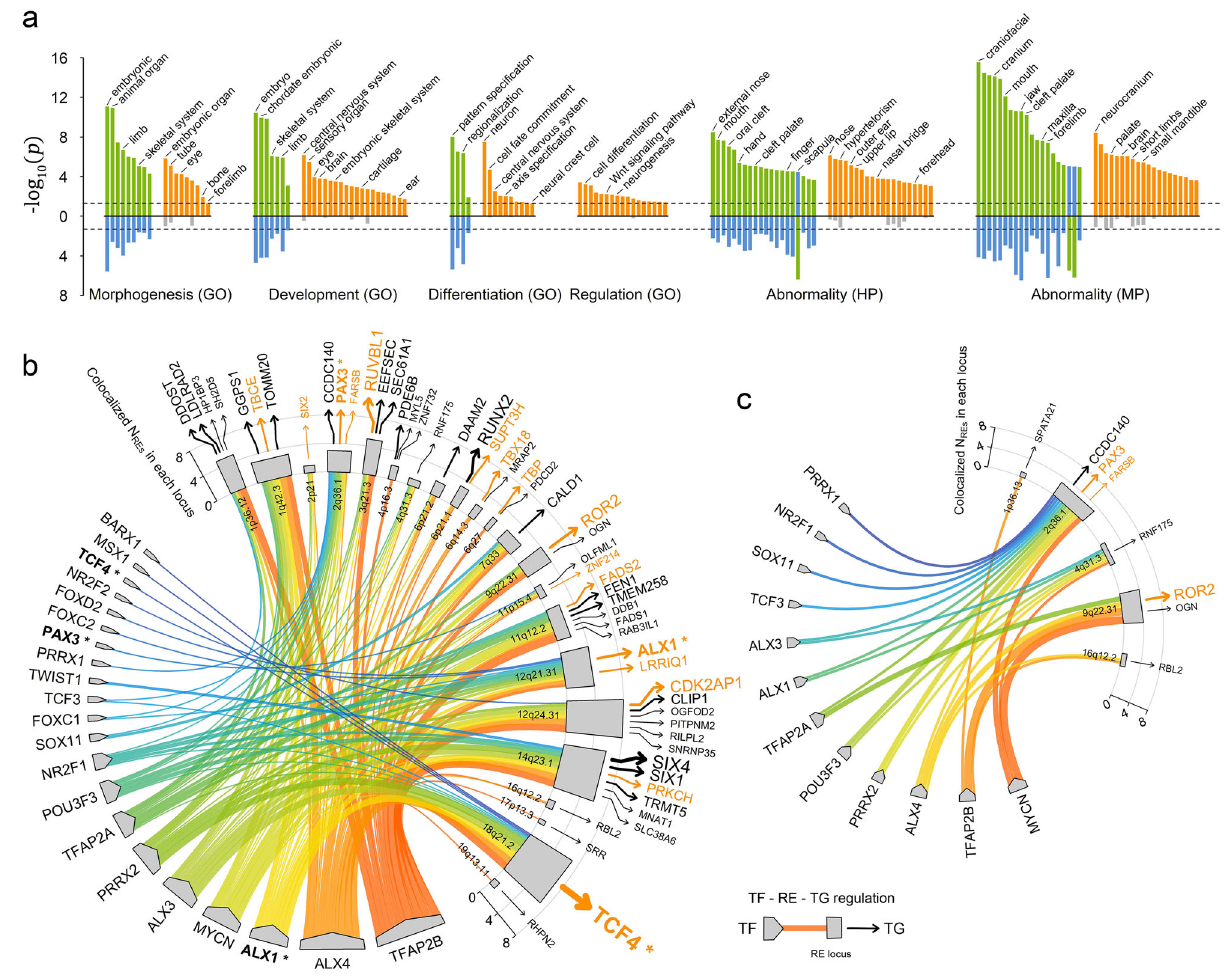
Fig. 6 | Biological annotation of signi fi cant fi ndings. a Gene ontology (GO), human phenotype ontology (HP), mouse phenotype ontology (MP) terms enrich- ment analyses were carried out based on C-GWAS (83 genes in 56 loci) and Min- GWAS(24genein17loci) fi ndings.BiologicaltermswiththeirBonferronicorrected enriched p -values from C-GWAS and MinGWAS were plotted above and below the black solid line, respectively. Shared and signi fi cant terms are indicated in green (more signi fi cant) or blue (less signi fi cant). Unique terms are indicated in orange with those non-signi fi cant in gray. The dashed lines indicate Bonferroni corrected